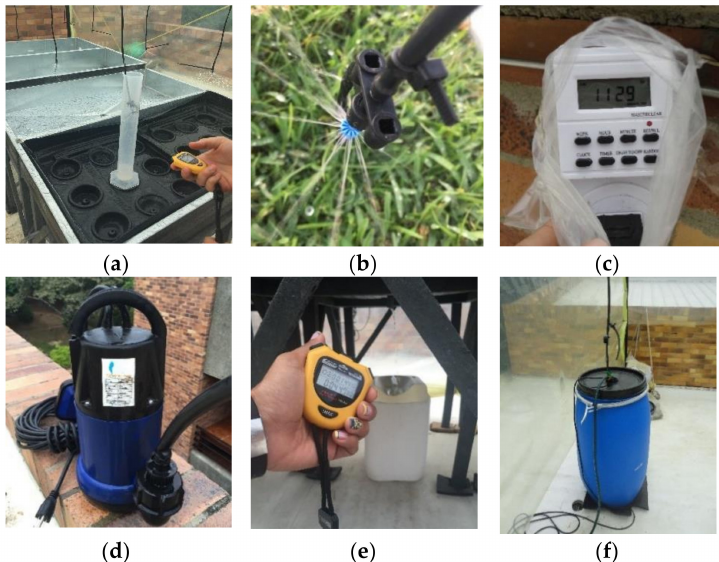
Figure 4. Calibration and rain simulation monitoring elements: ( a ) calibration test tube, ( b ) micro-spray nozzle, ( c ) timer, ( d ) submersible pump, ( e ) chronometer to measure drainage performance, and ( f ) tank for water supply for